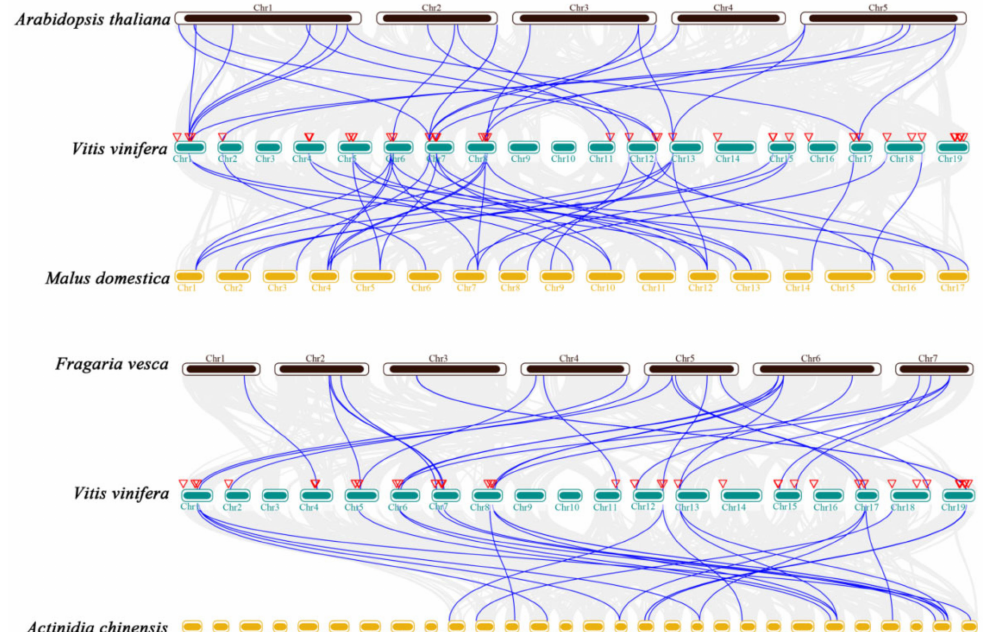
Figure 4. The synteny analysis of the GST genes between grape, Arabidopsis thaliana , Malus domestica , Fragaria vesca and Actindia chienesis . The blue lines indicate segmental duplicated gene pairs of grape GST genes with other species, while the gray lines delineate synteny blocks in the grape